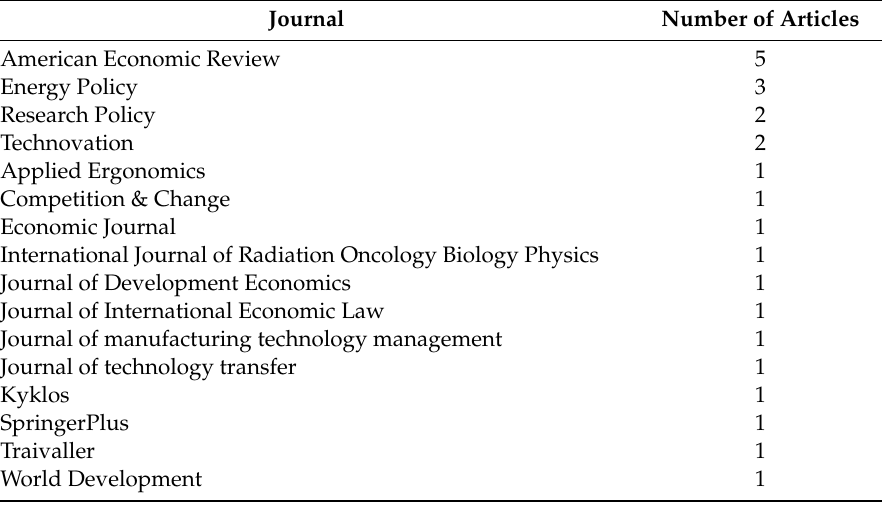
Table 3. Main Journals and frequencies of publications. Journal Number of